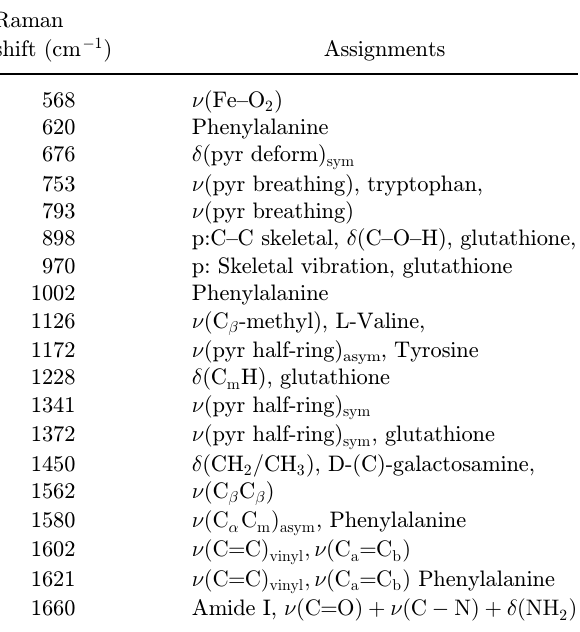
Fig. 4. ROC curve of the discrimination result using the PCA- LDA-based spectral classi¯cation. The integrated area under the ROC curve is